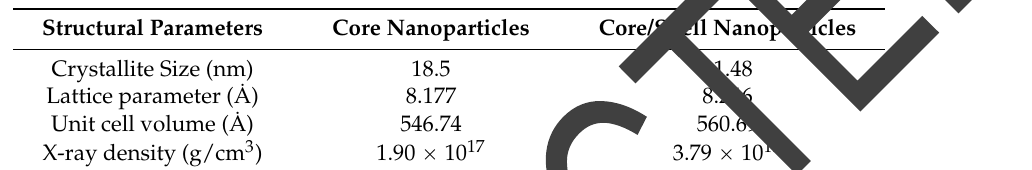
Table 1. Structural parameters calculated from X-ray diffraction (XRD)